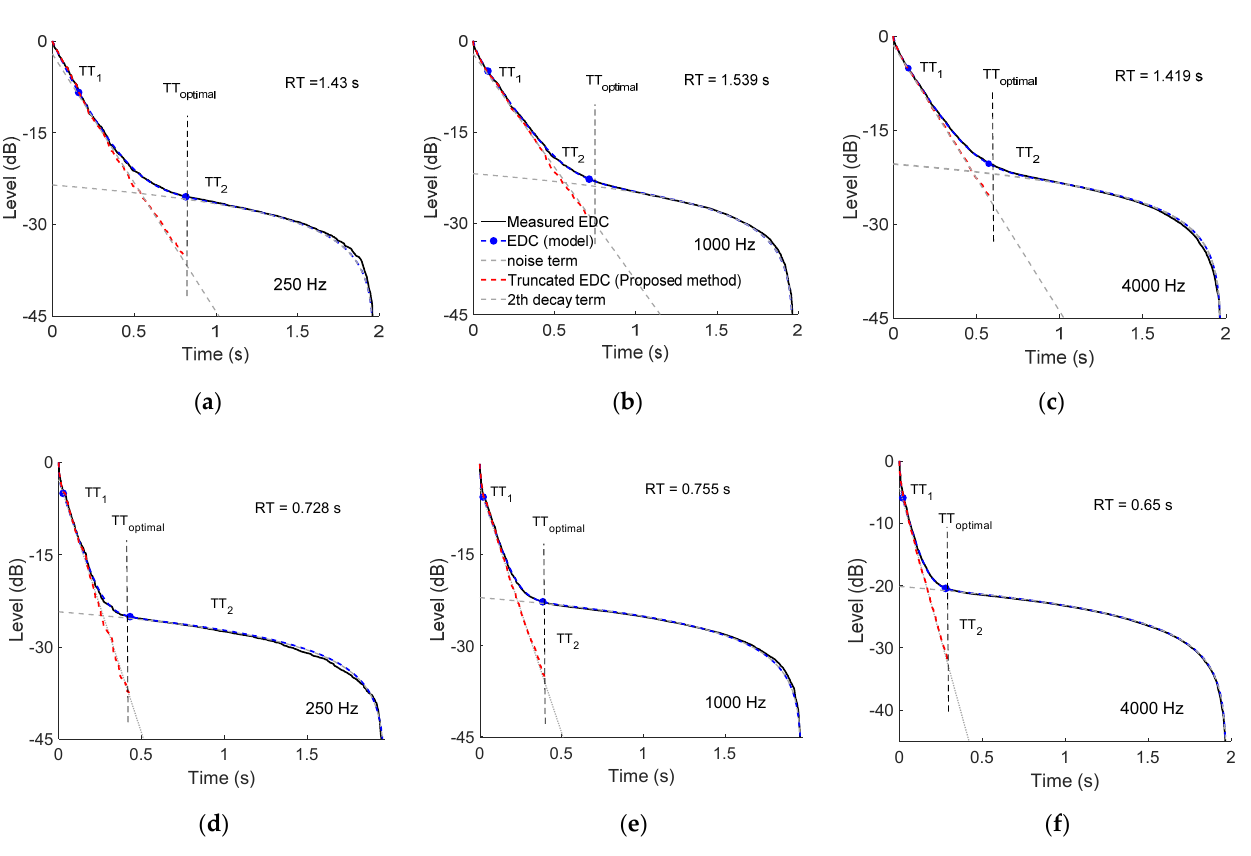
Figure 7. The normalized EDCs of the two measured RIRs having double-slope decays with ambient noise levels ( − 46 dB to − 50 dB) filtered in the octave band at the 250 Hz, 1 kHz and 500 Hz, which generated from Equation (7), as well as the comparison of the corresponding TT 2 to TT optimal of the RIR with ambient noise levels ( − 56 dB to − 66.6 dB). Table 2. Comparison of DTs between the measured RIRs with two noise